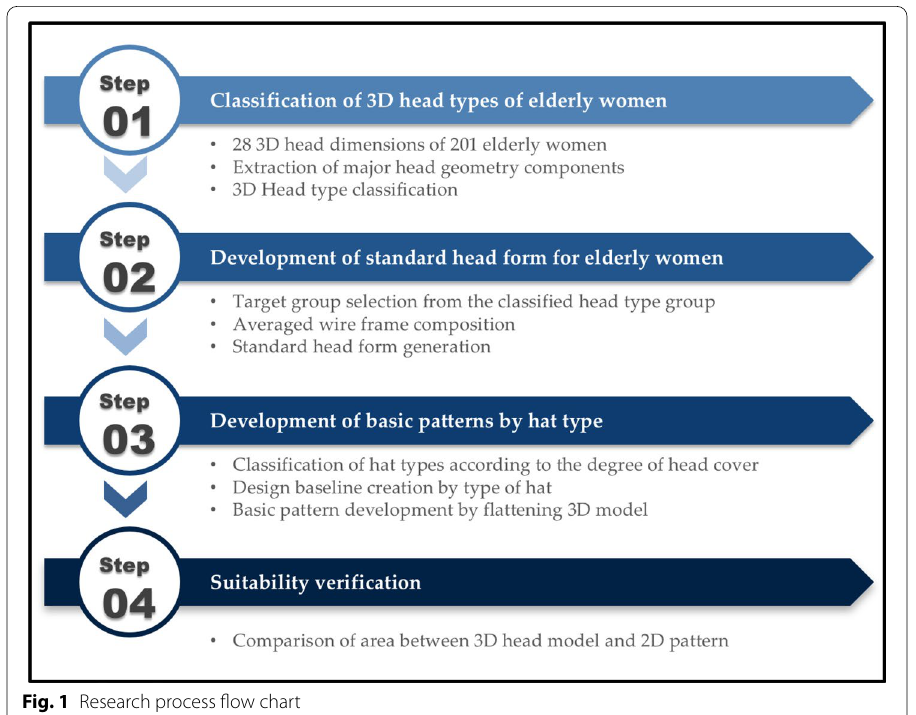
Fig. 1 Research process flow chart